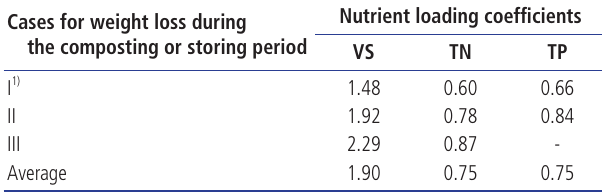
Table 5. The nutrient loading coefficients for VS, TN, and TP from dairy cattle manure according to three cases Cases for weight loss during the composting or storing